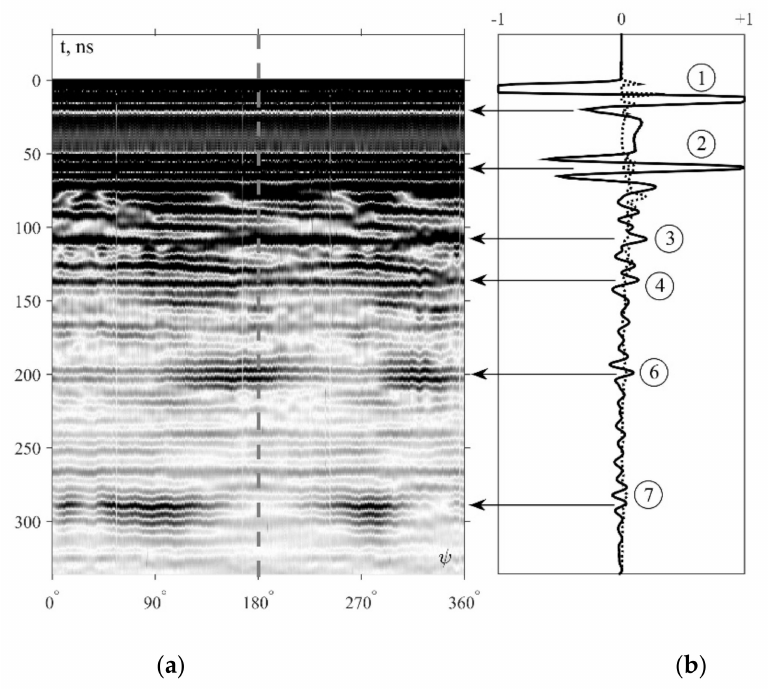
Figure 5. ( a ) Return pulse evolution by 360 degrees antenna rotation—primary data (B-scan). ( b ) ( 1 ). direct wave; ( 2 ) reflected wave from the ground surface; ( 3 ) reflected wave from the interface at a depth of 2.5 m; ( 4 ) reflected wave from the interface at a depth of 4 m; ( 6 ) reflected wave from the crane boom; ( 7 ) reflected wave from the crane